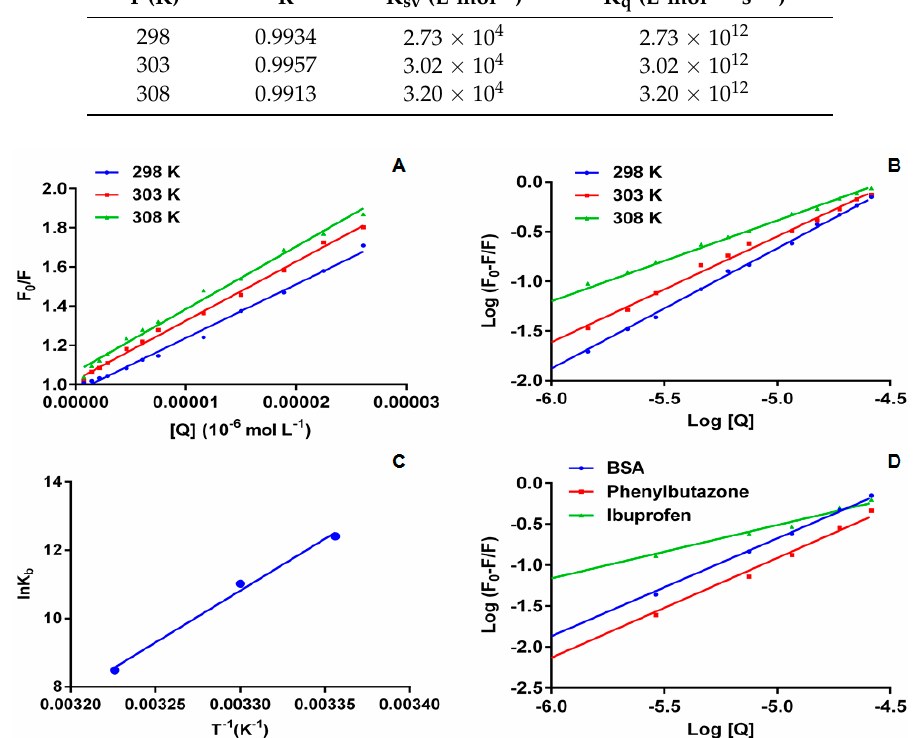
Table 1. Stern–Volmer quenching constants (K SV ) and bimolecular quenching rate constant (K q ) for the binding of 6P to BSA at three variable temperatures.